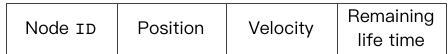
Figure 6. Format of the improved HELLO packet.